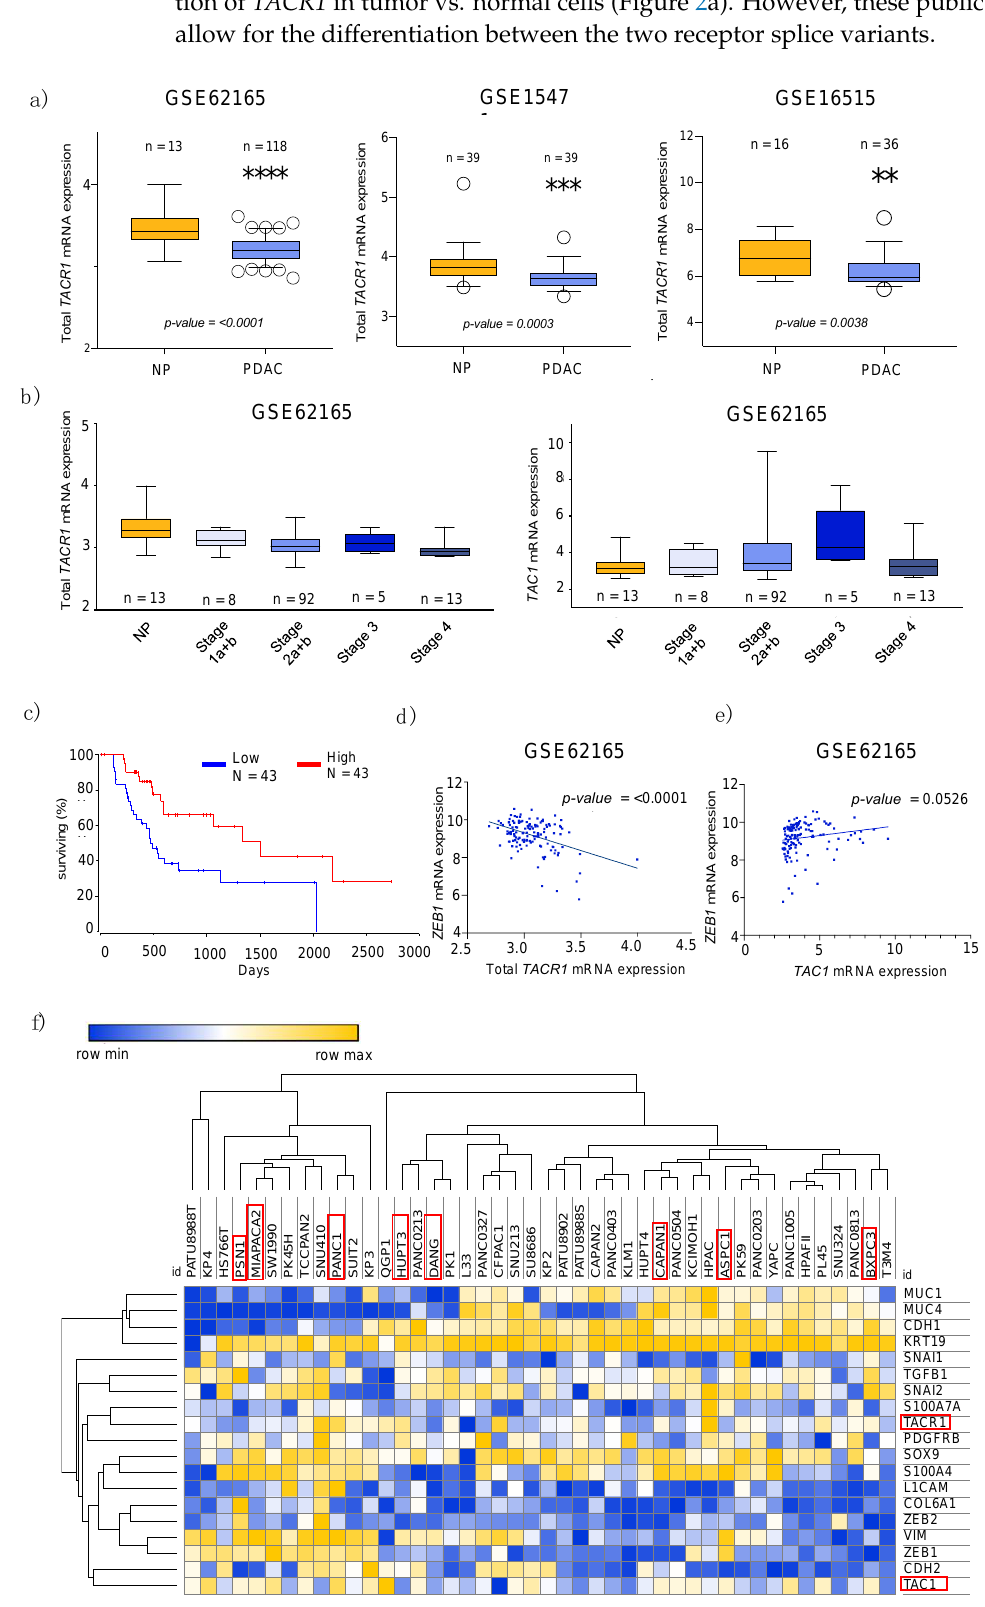
Figure 2. Transcriptome-based data analysis. ( a ) Boxplots demonstrating significantly lower mRNA expression levels of TACR1 in PDAC compared to normal tissue (NP) in the indicated transcriptomic data series. p -values were calculated using unpaired t -test. ( b ) TACR1-total and TAC1 gene expression in different pancreatic cancer stages obtained from the indicated GEO data set. ( c ) Prognostic significance of TACR1-tr (top and bottom 25% gene expression) in PDAC, assessed by